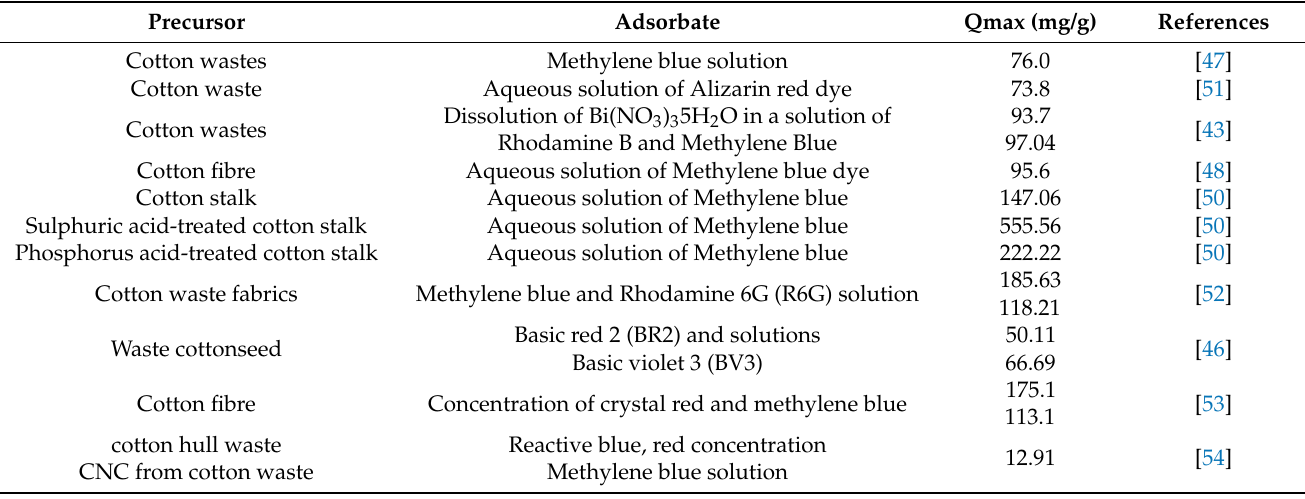
Table 1. Adsorption efficiency of textile wastes for